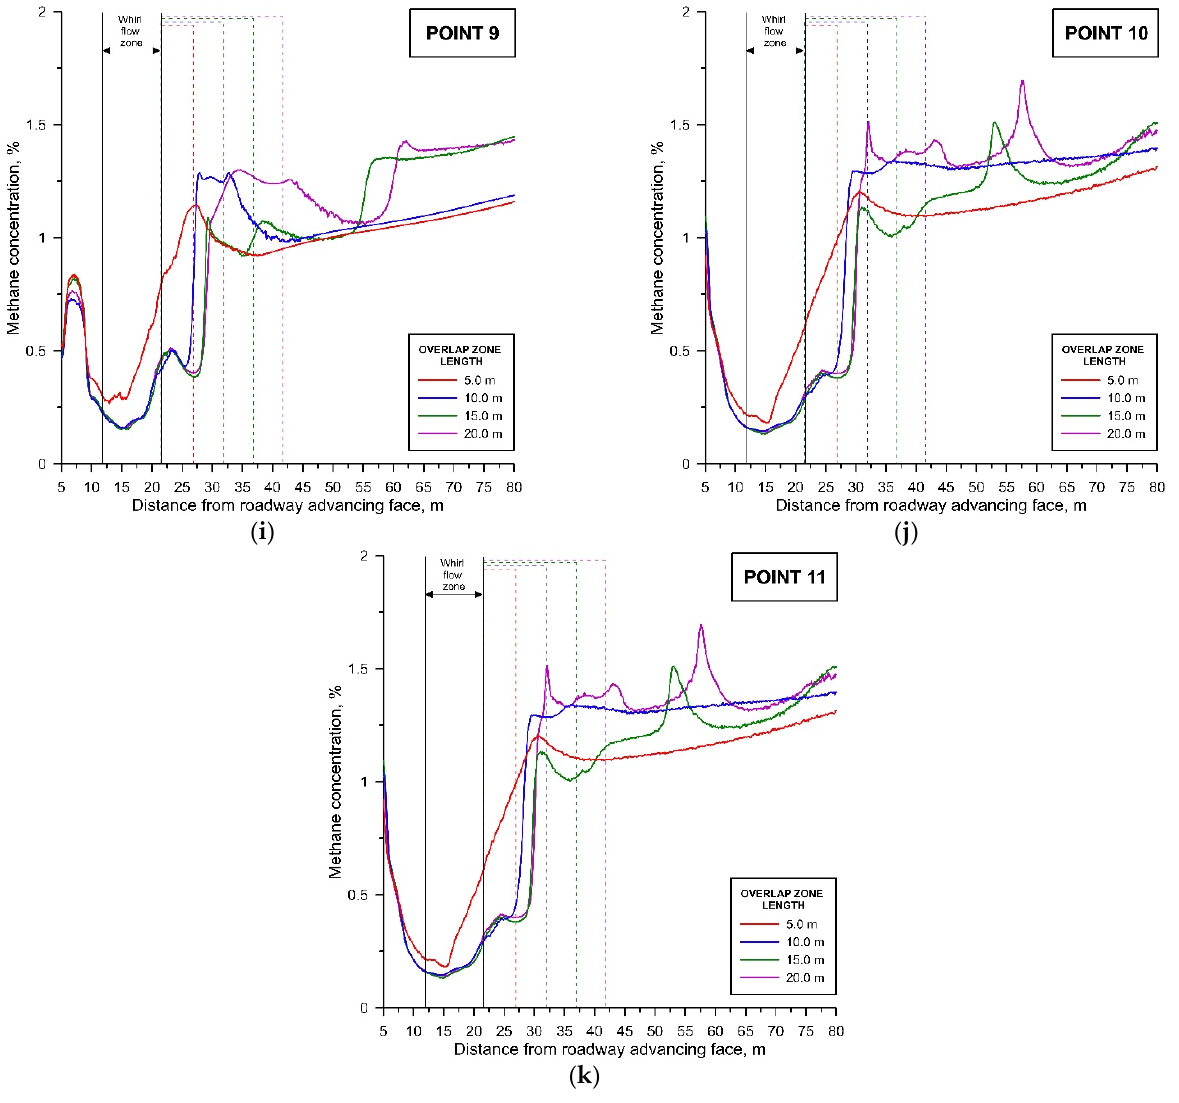
Figure 17. Methane concentration at measurement points within the roadway, acc. to Figure 16, ( a ) point 1; ( b ) point 2; ( c ) point 3; ( d ) point 4; ( e ) point 5; ( f ) point 6; ( g ) point 7; ( h ) point 8; ( i ) point 9; ( j ) point 10; ( k ) point 11.